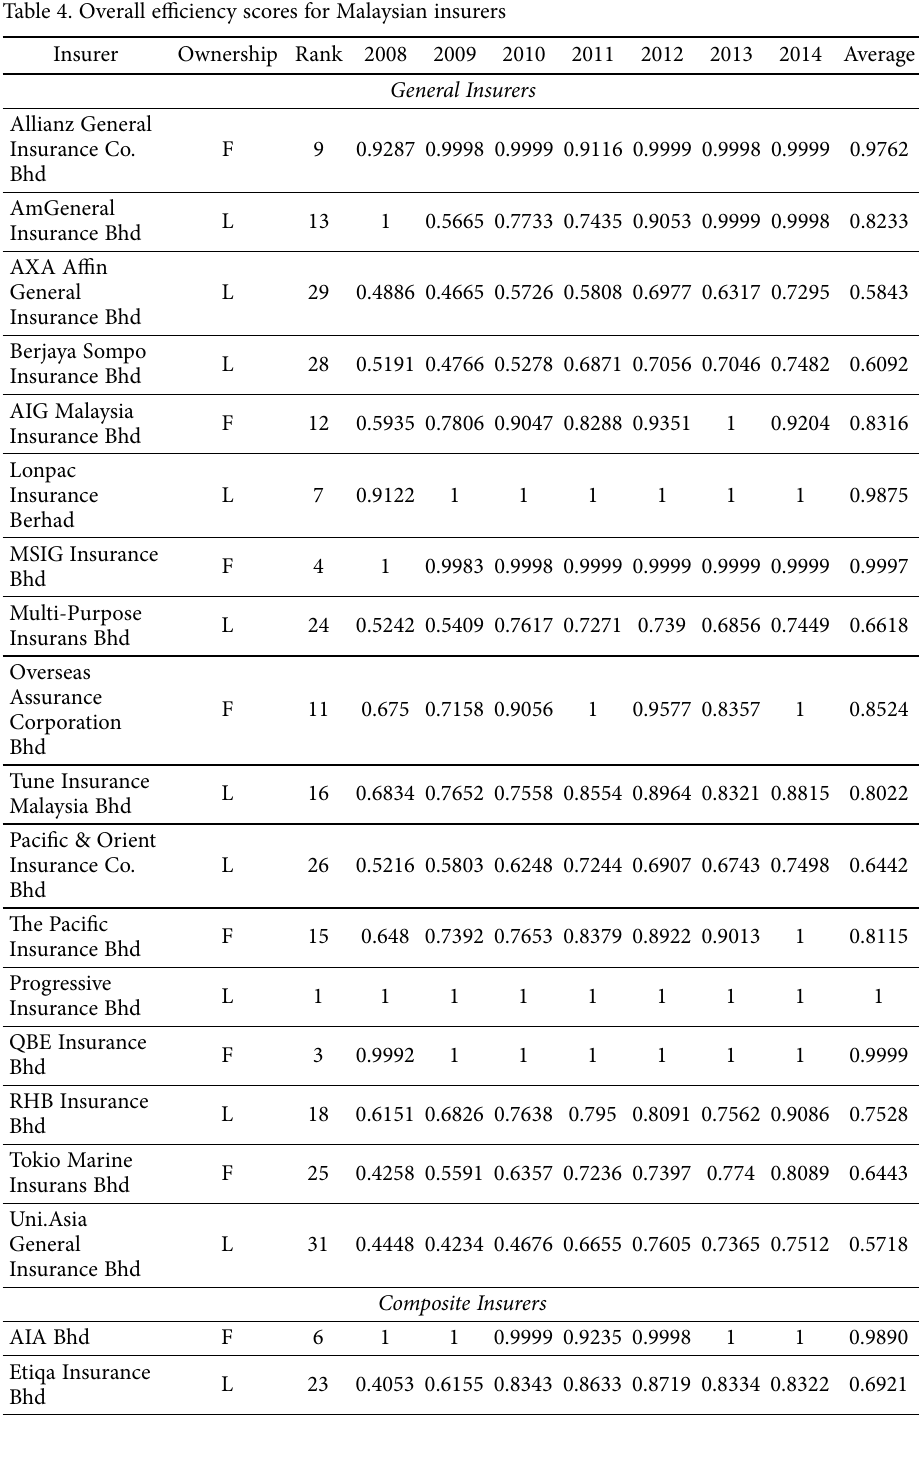
Table 4. Overall efficiency scores for Malaysian insurers